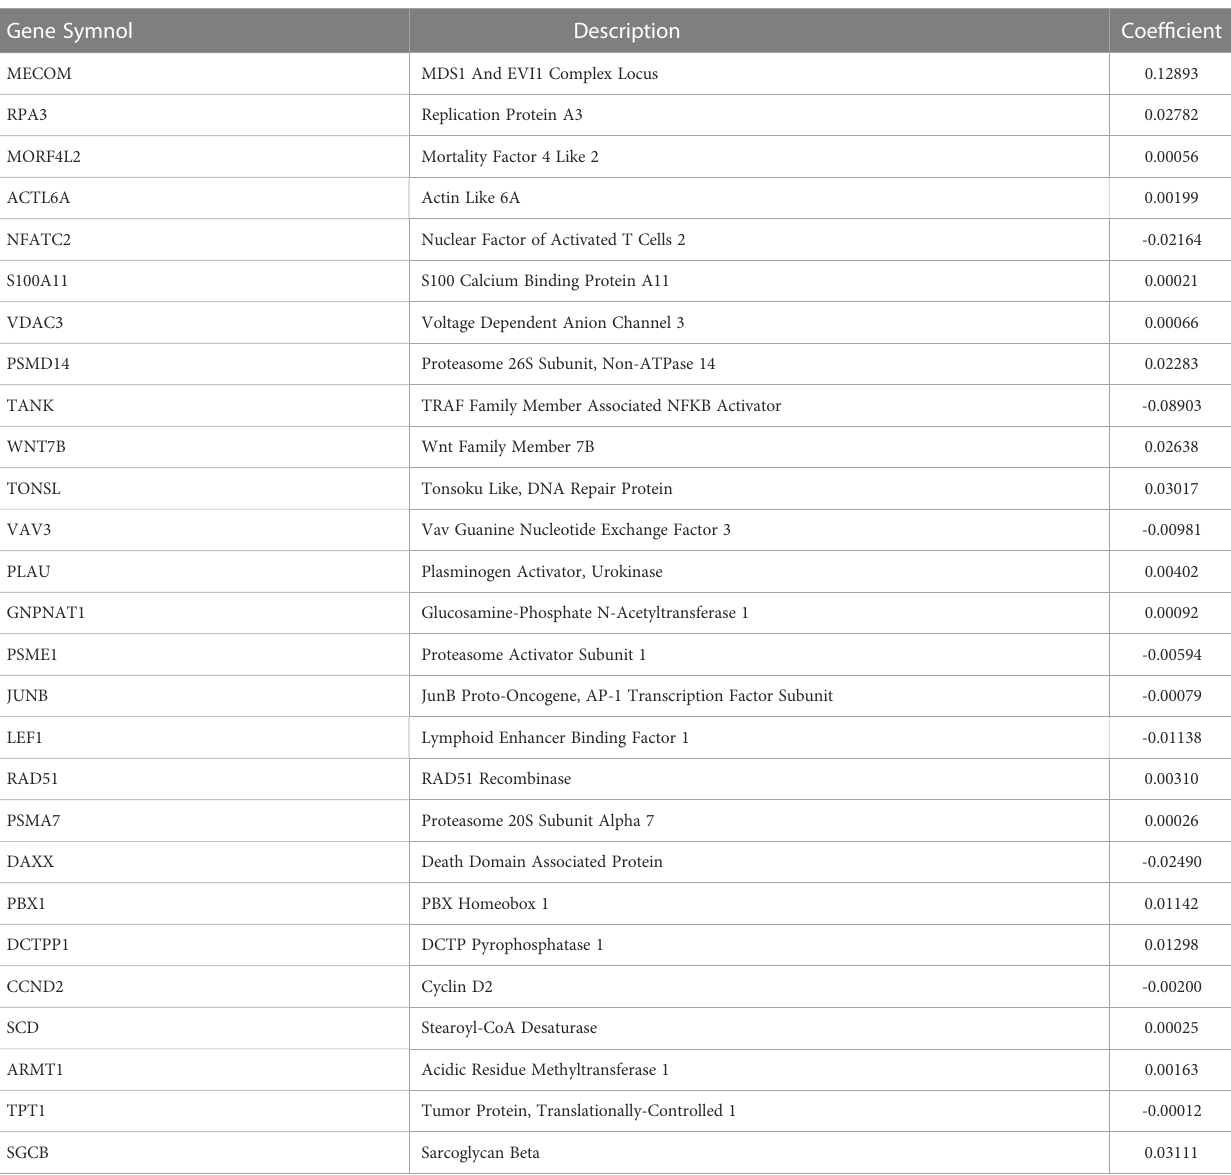
TABLE 1 Coef fi cients of the signature